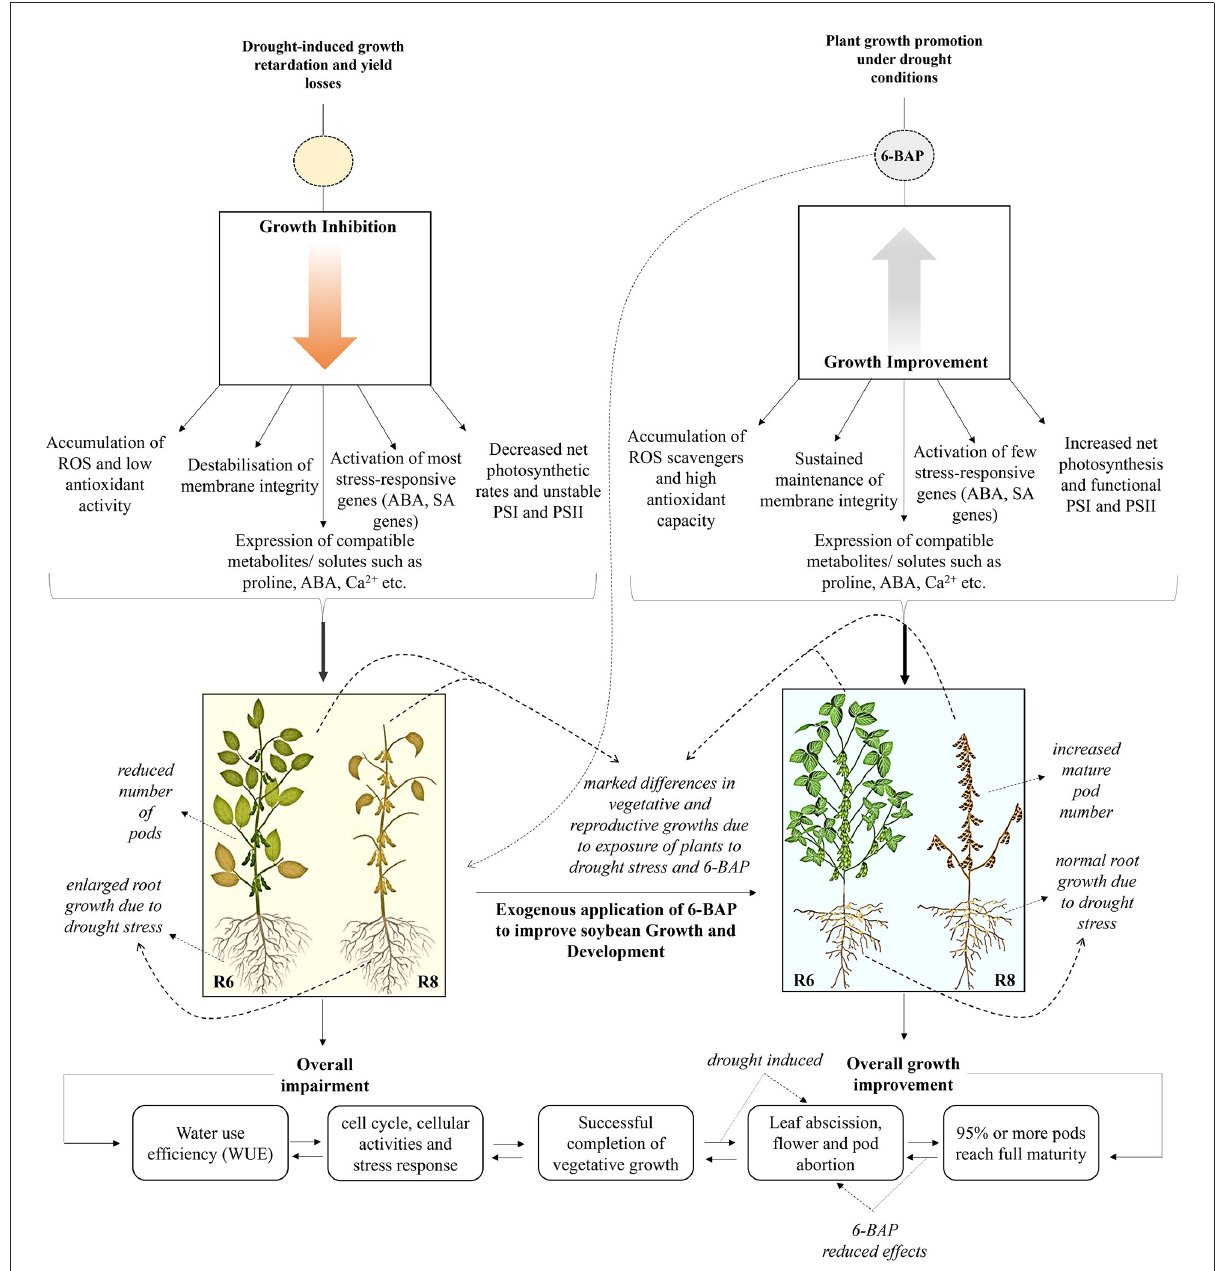
FIGURE5 Summary of the effects of 6-BAP on the growth and development of soybean plants following the exposure of the plants to drought stress.